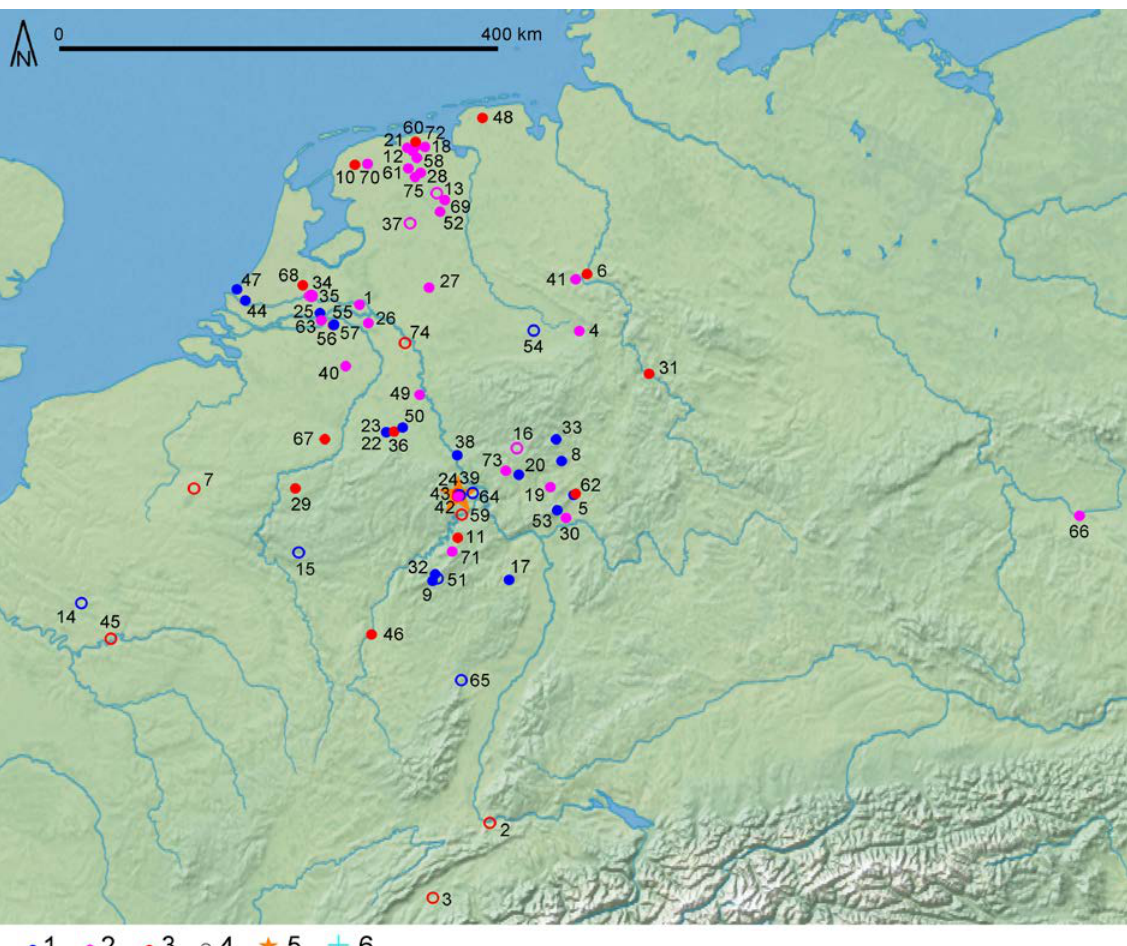
Figure 11. Localisation of findspots of Brillery type querns. Numbers refer to the supplementary list of findspots. 1. La Tène C-D; 2. undated; 3. Roman; 4. atypical, or runner, or possibliy not Mayen lava; 5. Bellerberg volcano near Mayen; 6. salt production site. Base map: Natural Earth II, version 2.0.0,